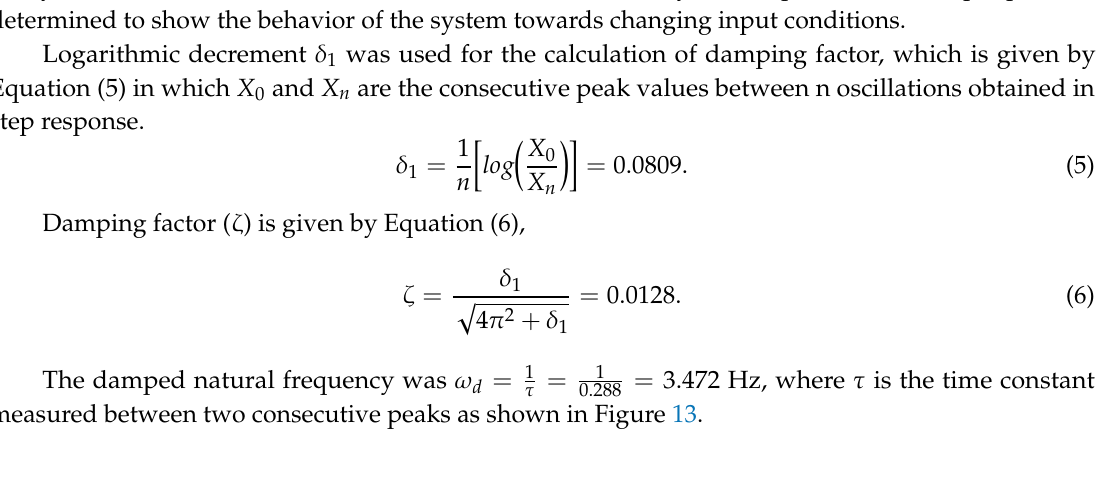
Figure 13. Comparison of theoretical, FEA and experimental force deflection.